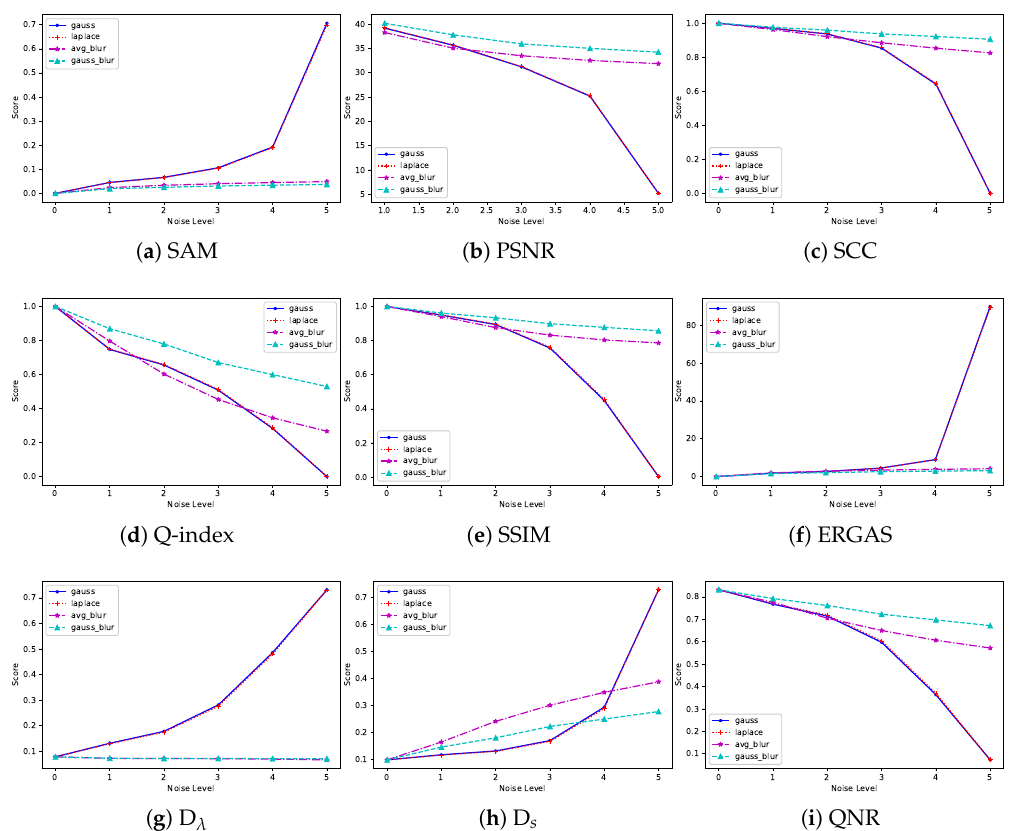
Figure 5. The score trend of different indexes with respect to the level of noise. On the x -axis, a greater number means a higher noise